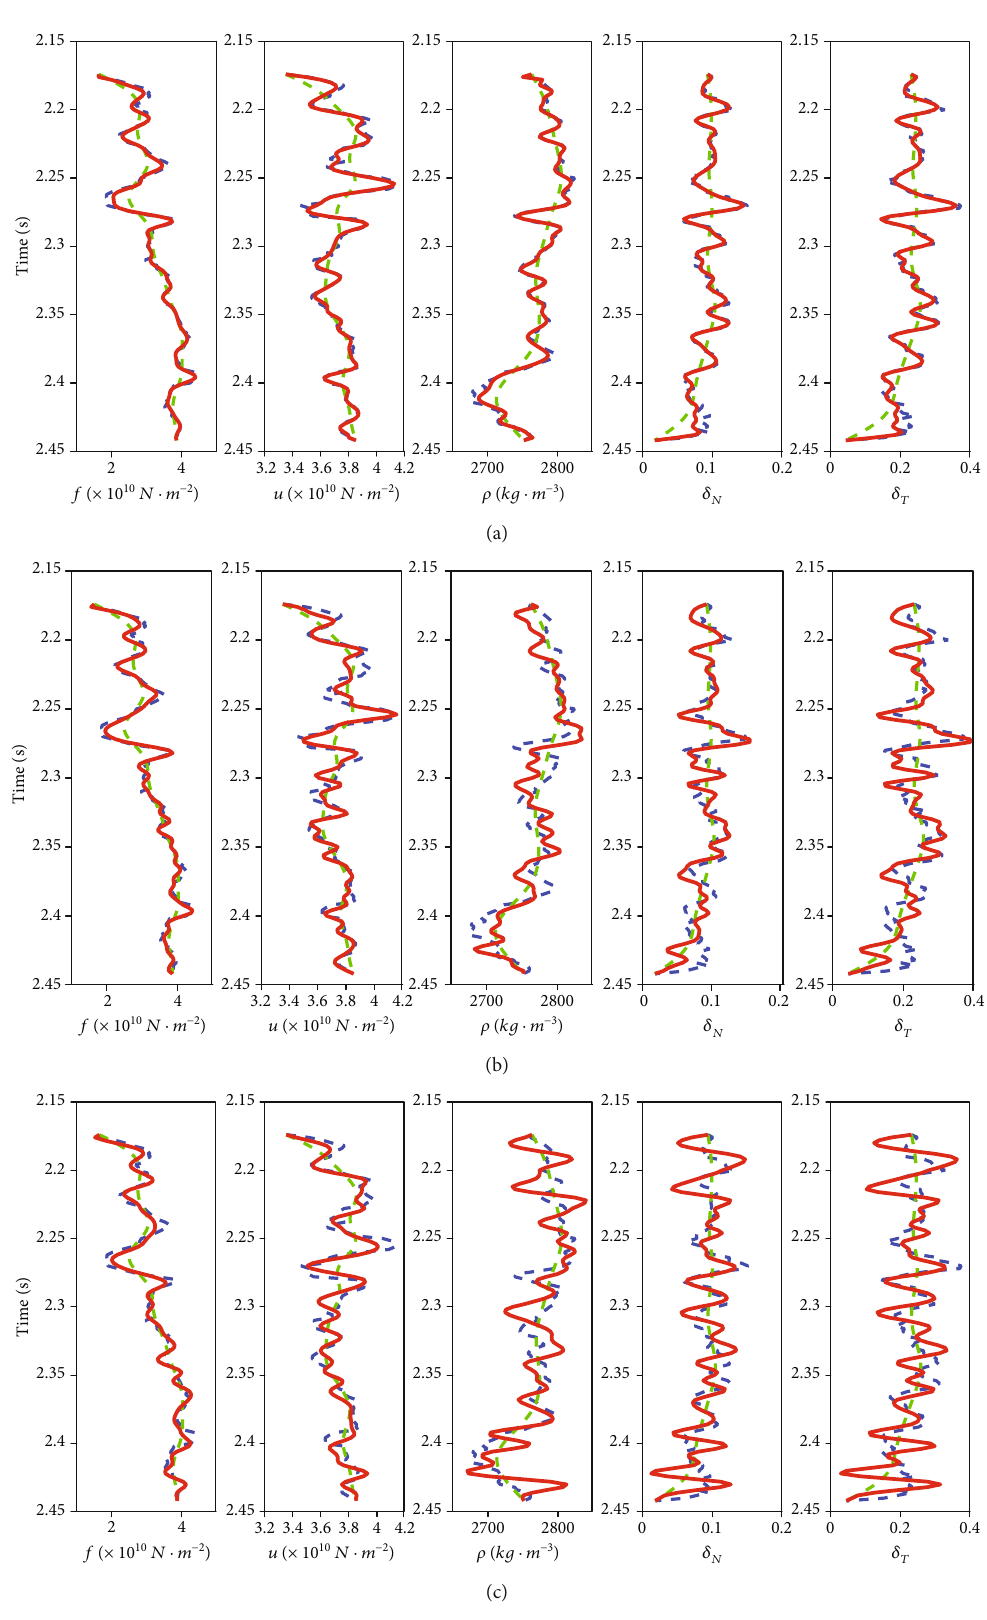
Figure 9: Comparison between the original (blue), initial (green), and inverted (red) fl uid/porosity term, shear modulus, density, and fracture weaknesses using the synthetic data with di ff erent SNRs, where (a) is noise free, (b) is 5, and (c) is